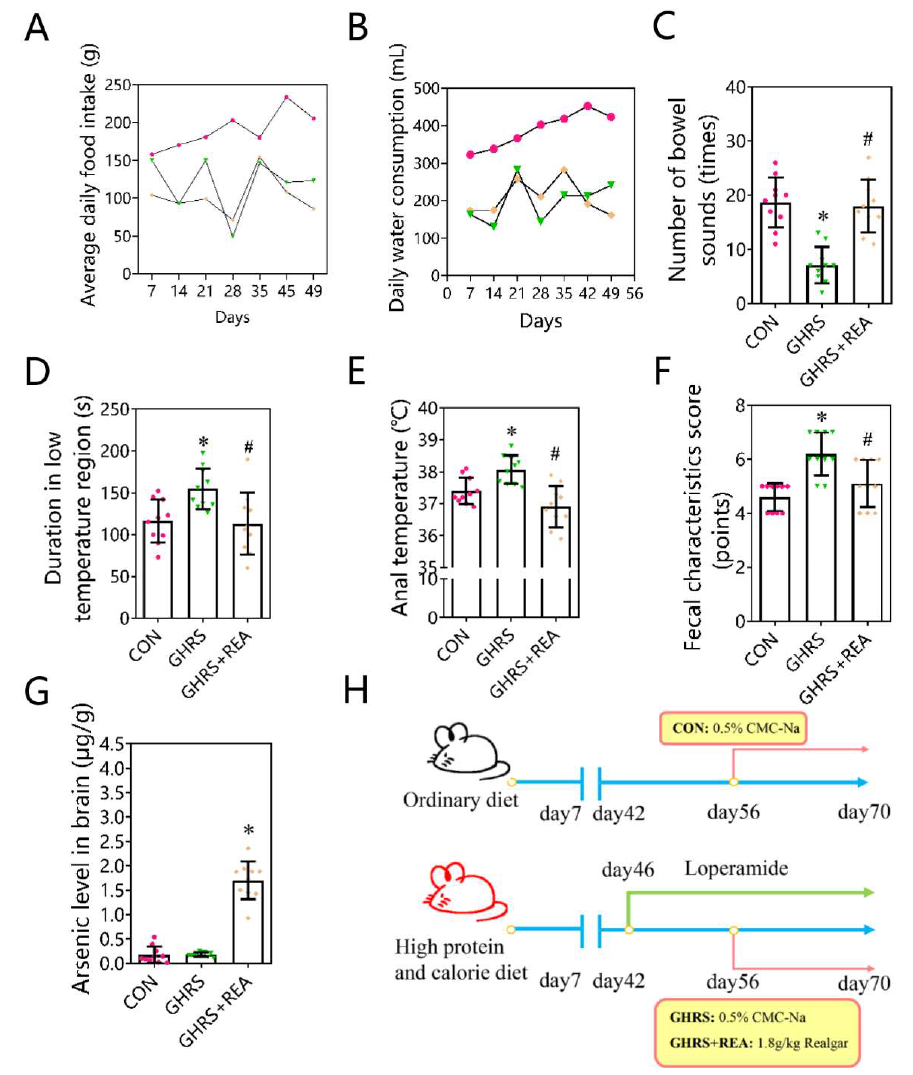
Figure 1. The macroscopic characteristics demonstrating that realgar alleviates the GHRS symptoms in the rats. ( A ) Food intake; ( B ) water consumption; ( C ) number of bowel sounds; ( D ) duration in low temperature region; ( E ) anal temperature; ( F ) fecal characteristics score; ( G ) arsenic level in the brain; ( H ) the experimental procedure of GHRS rat model. The pink spots represent the CON group; green spots represent the GHRS group, and the yellow spots show the GHRS + REA group. The number of animals per group was 10. Each column represents the mean ± SD. * p < 0.05 compared with CON group, # p < 0.05 compared with GHRS group.